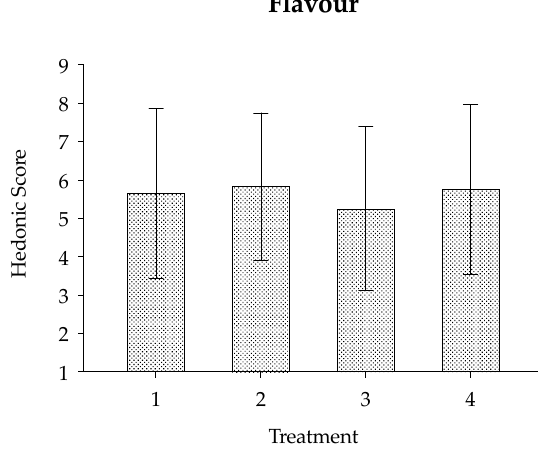
Figure 2. Panellists ( n = 111) rated the flavour of four probiotic yogurt treatments using a nine-point hedonic scale ranging from 1 (dislike extremely) to 9 (like extremely). A one-way repeated-measures ANOVA and Fisher’s least significant difference test were used to analyse statistically significant differences ( p < 0.05) between mean hedonic scores. (Treatment 1 indicates 100% cow milk (control); Treatment 2, 75% cow milk + 25% soymilk; Treatment 3, 50% cow milk + 50% soymilk; Treatment 4, 25% cow milk + 75% soymilk).